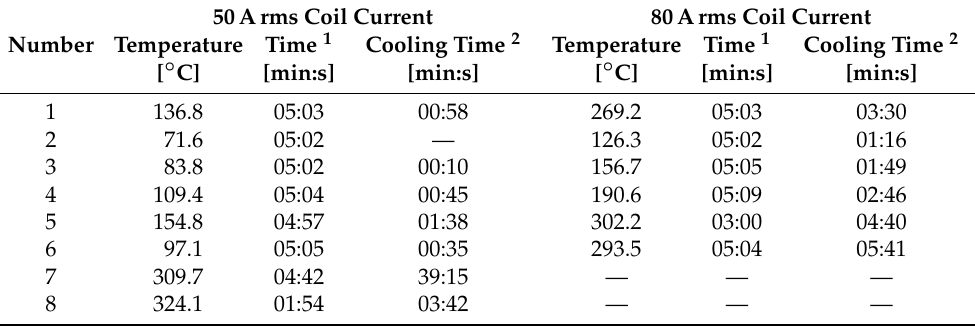
Table 4. Thermal behavior of the test